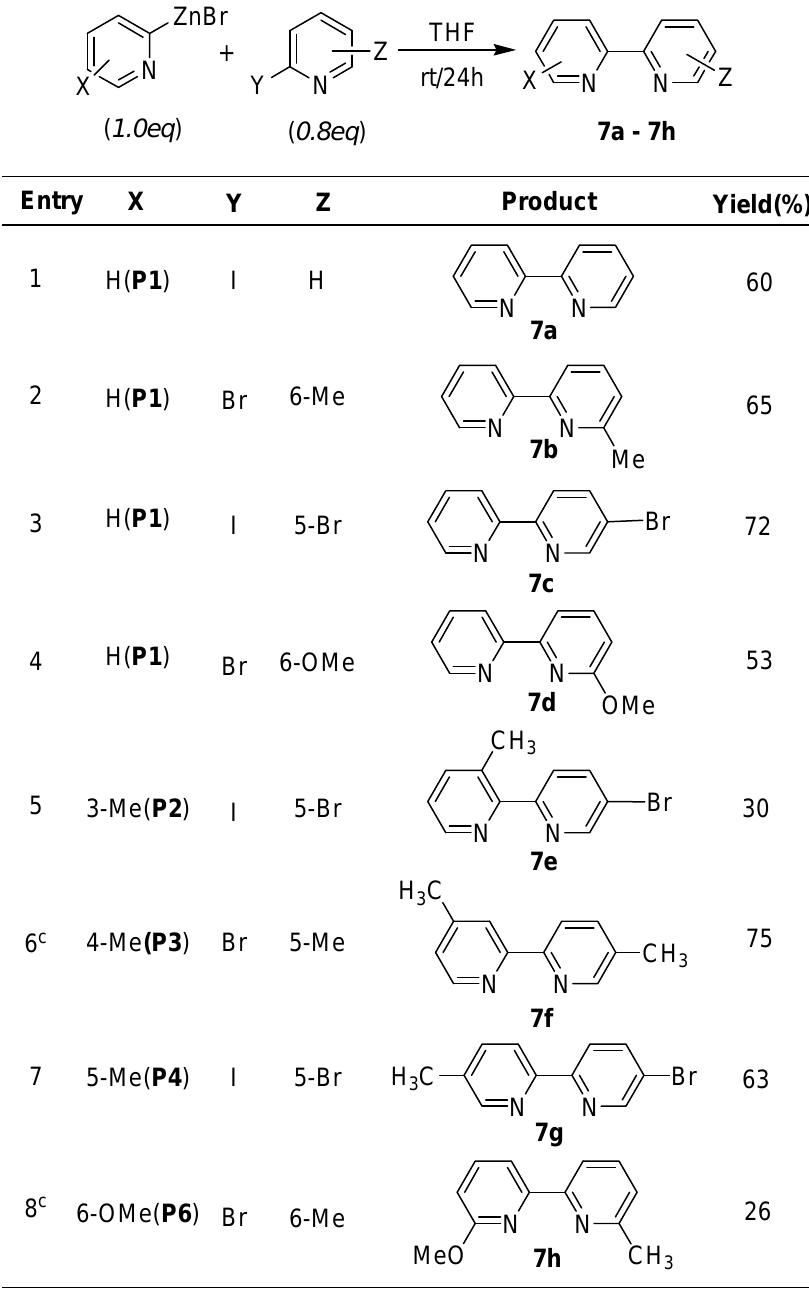
Table 7. Preparation of 2,2’-bipyridines a